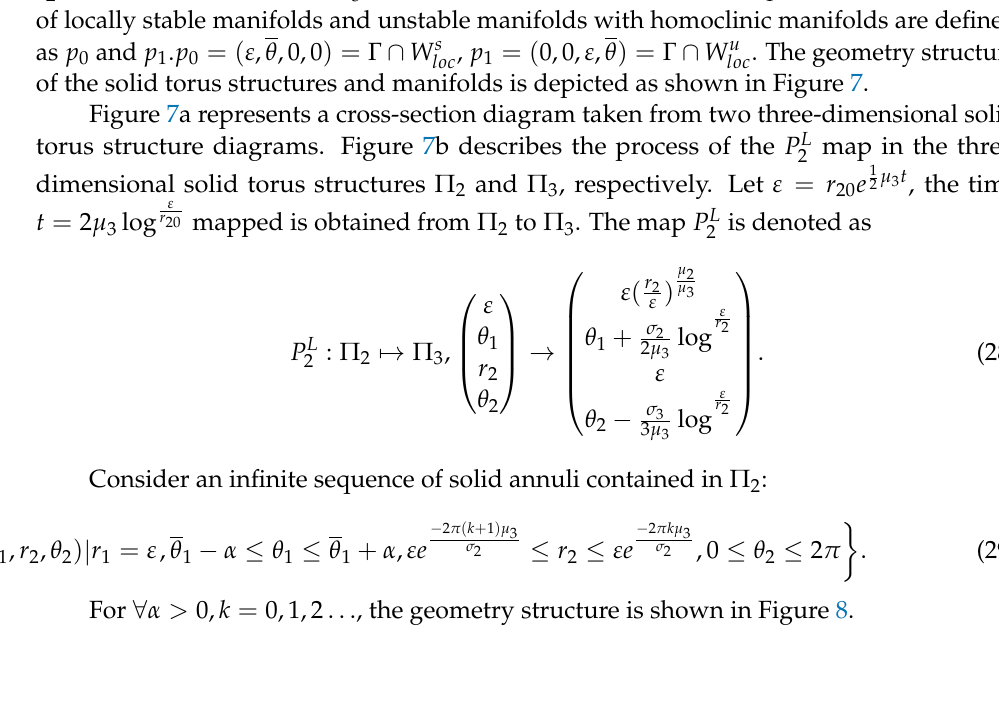
Figure 6. The positional relationship when c 1 Figure6. The positional relationship when 1 relationship between fixed point and periodic relationship between fixed point and periodic orbit.